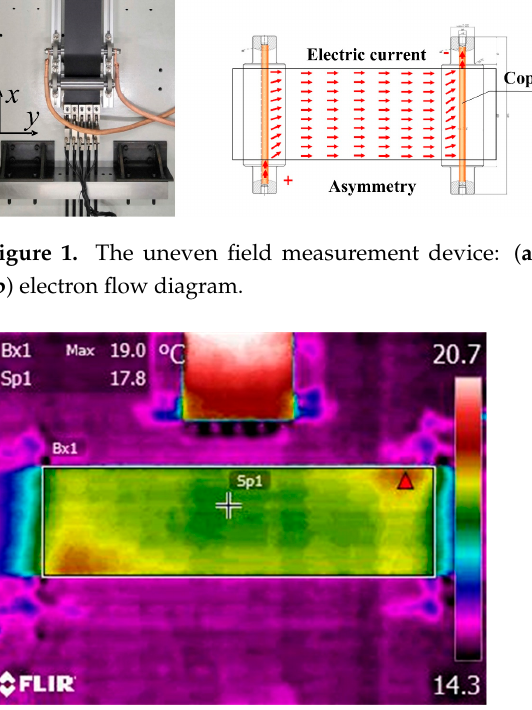
Figure 2. The Mg strip thermal imaging of the tensile device with wrap angle.